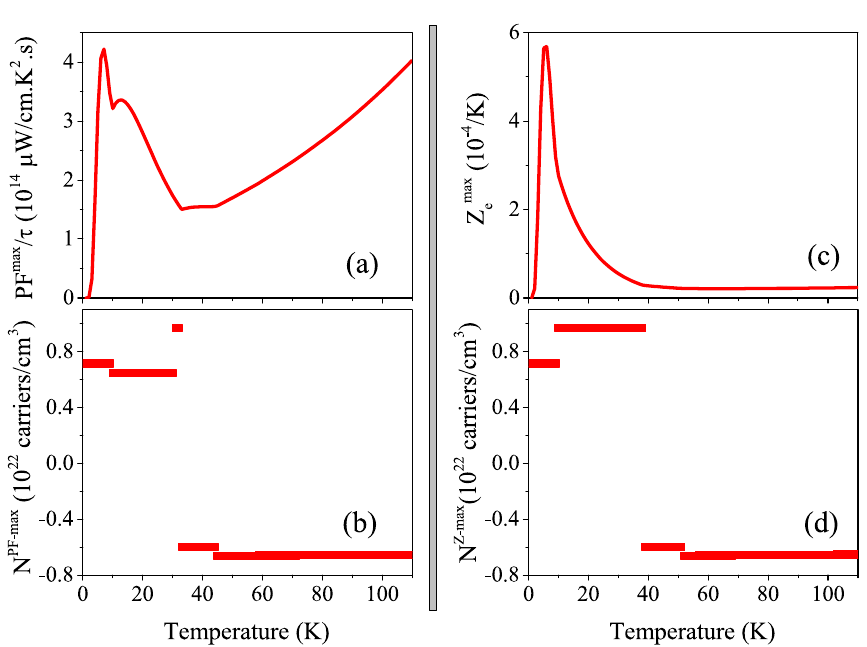
Figure 14. Maximum values of ( a ) power factor per relaxation time (PF max /τ ) and ( b ) electronic figure of merit (Z max e ) versus temperature for T ≤ 100 K calculated by GGA+U with U eff = 5.5 eV at P = 0 pressure. Doping levels related to the PF max /τ and Z max e are displayed in ( c ) and ( d ),